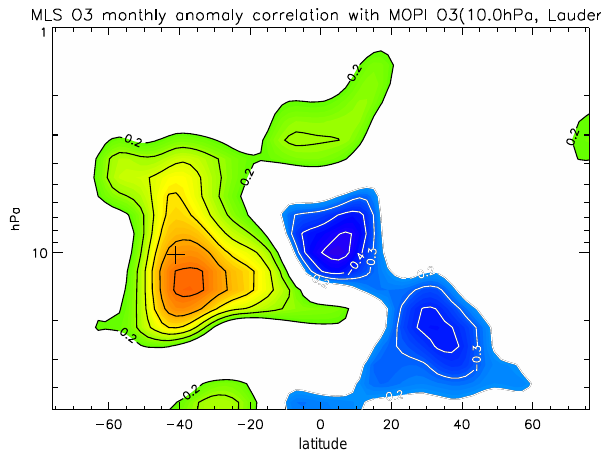
latitude Figure 8. The correlation coefficient of the monthly MLS O 3 anomalies with the monthly anomalies of the MOPI1 O 3 mea- surements at 10hPa. The cross represents the latitude of Lauder at 10hPa. Contour lines are shown for r = ± 0.2, 0.3, 0.4, 0.5, 0.6, and